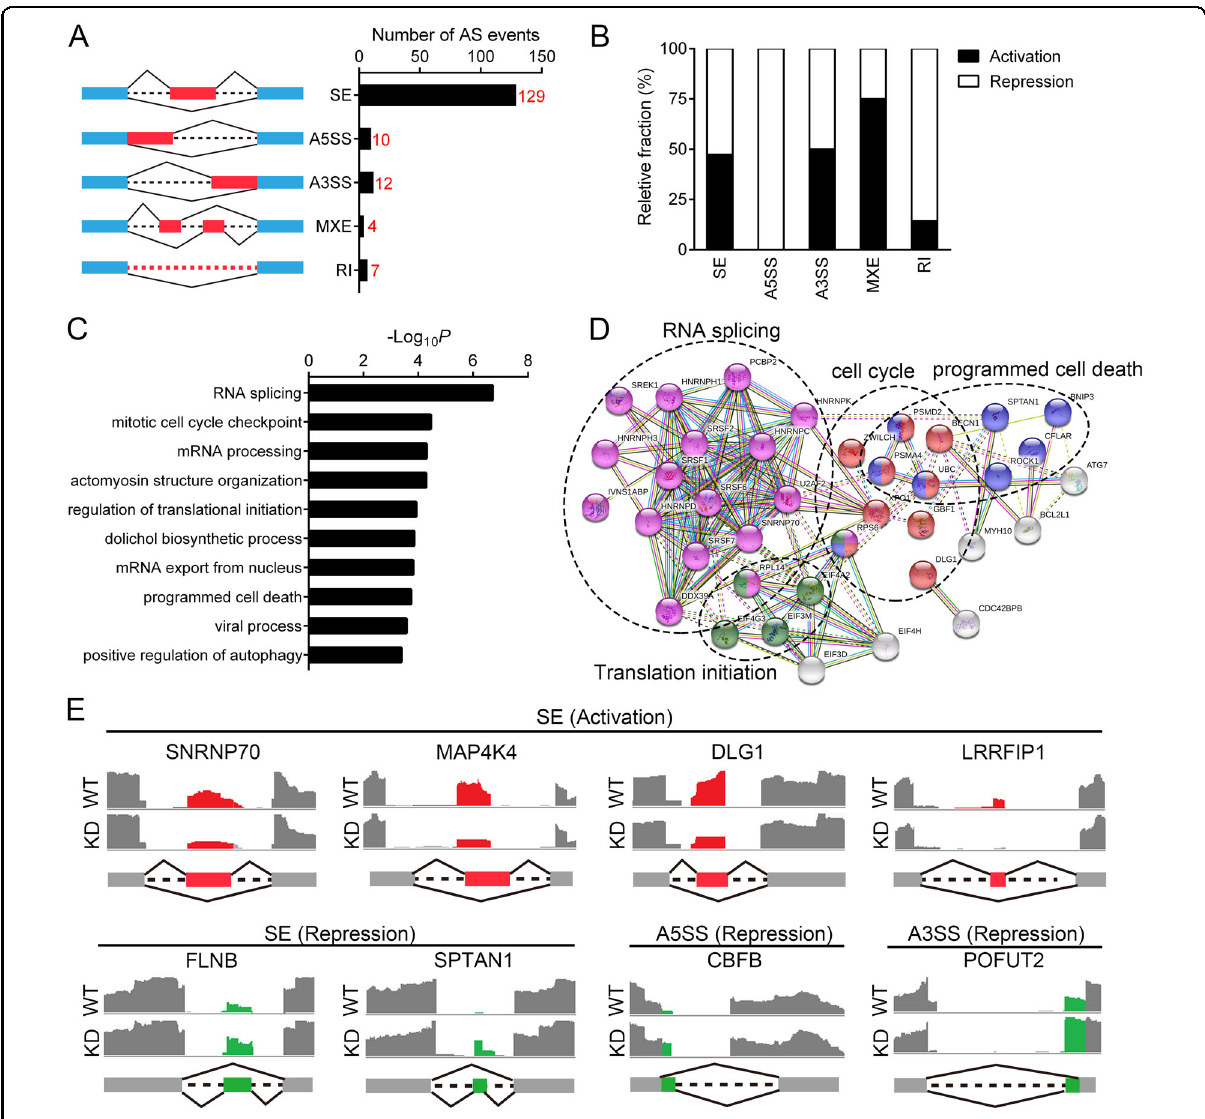
Fig. 6 Global pro fi les of Pontin-affected AS in U87MG cells. A Diagrams of the exclusion and inclusion isoforms for the fi ve modes of AS events examined (left) and the graph of Pontin-affected AS events in each category (right). SE skipped exon, A5SS alternative 5 ’ splice site, A3SS alternative 3 ’ splice site, MXE mutually exclusive exon, RI retained intron. B Relative fraction of AS events affected positively (activation) or negatively (repression) by Pontin in each category. C GO annotation results of the AS targets affected by Pontin knockdown. – Log 2 transformed fi sher exact P values are plotted for each enriched functional category. D Functional association network of the Pontin-affected AS targets. Genes incorporated in ( C ) were analyzed using the STRING database, and the subgroups are marked according to their functions. E Pontin can promote both exon inclusion and exclusion in vivo. Pontin-activated cassette exons (upper) and Pontin-repressed cassette exons (bottom) identi fi ed by RNA-seq are schematically diagrammed with mapped RNA-seq reads that cover the corresponding exons. Colored boxes, alternative exons; dashed lines, introns; gray boxes, fl anking constitutive